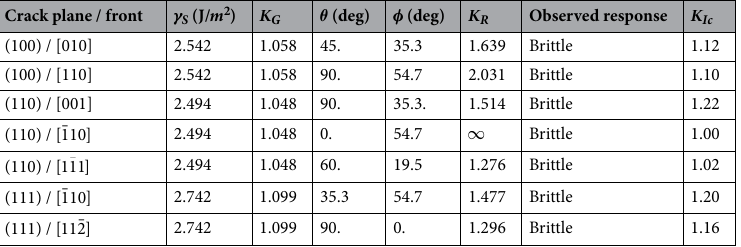
Table 1. Crack-system dependence of various critical stress intensity factors (MPa √ m ). See the main text for the details.